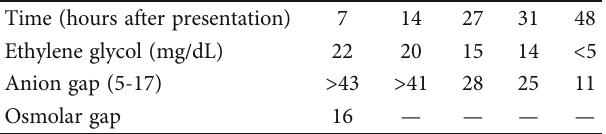
Table 2: Urine studies.